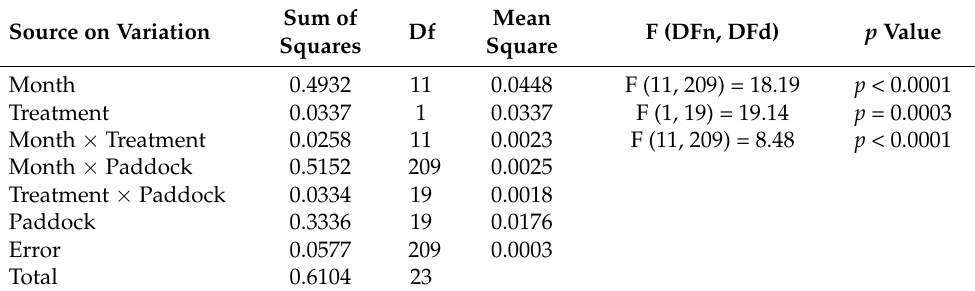
Table A6. Enhanced Vegetation Index (EVI) two-way repeated measure ANOVA of Natural Grassland (NG) and Natural Grasslands overseed with Legumes with Phosphorus fertilization (NG-LP), during 9 years after intensification practice, between January and December ( n = 20). Source on Variation